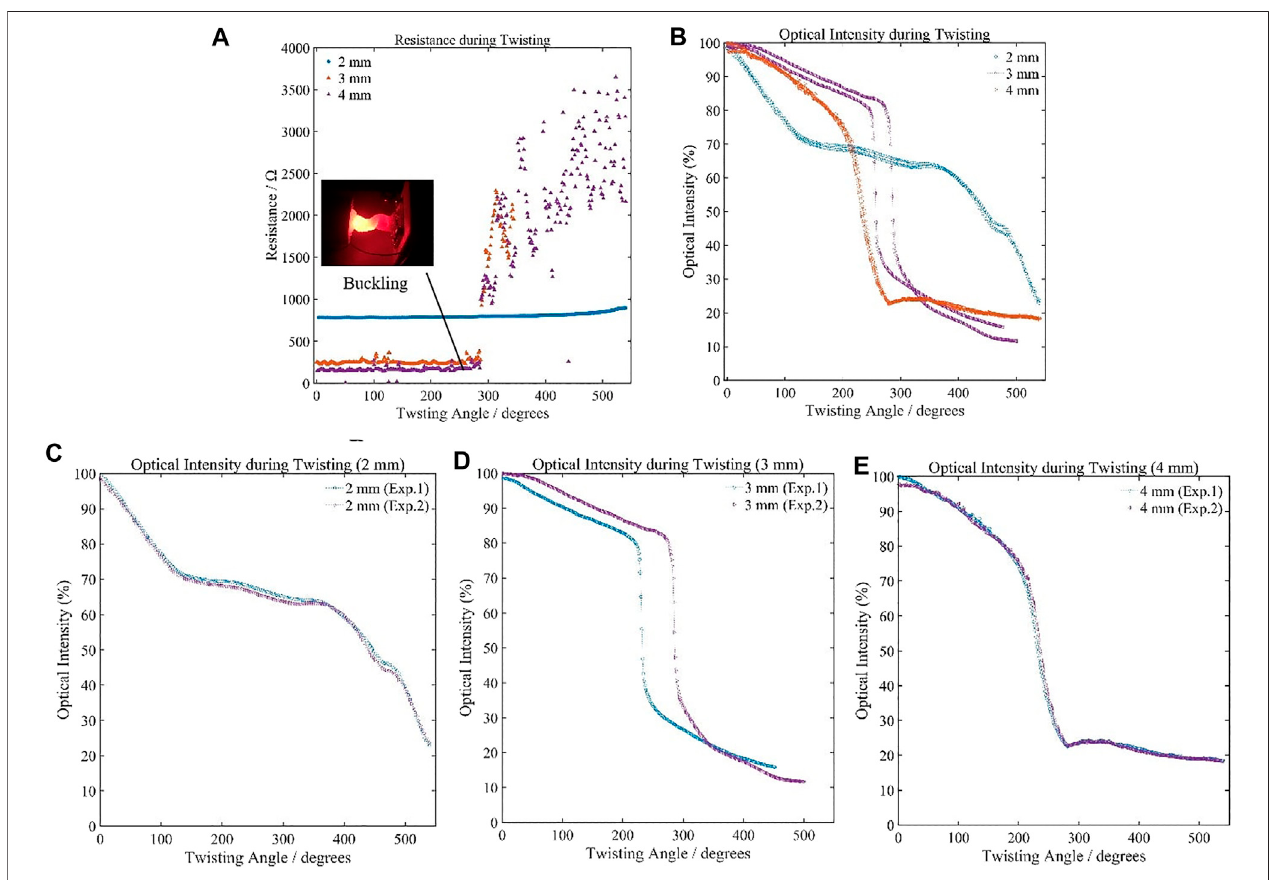
FIGURE 7 | Resistance and optical intensity variation during twisting. (A) Sensing Resistance performances of the MHS Sensor with three different diameters. (B) Sensing optical intensity performances of the MHS Sensor with three different diameters. (C) Optical intensity variation of 2-mm-diameter sensor during twisting. (D) Optical intensity variation range of 3-mm-diameter sensor during twisting. (E) Optical intensity variation range of 4-mm-diameter sensor during twisting.